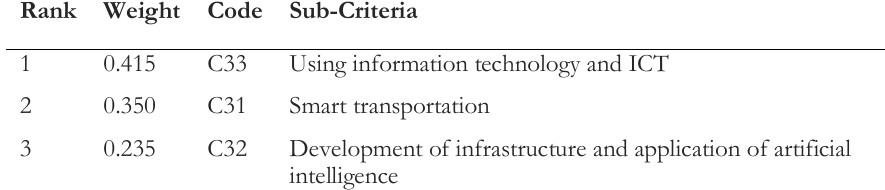
Table 9. Weight and rank of smart marketing